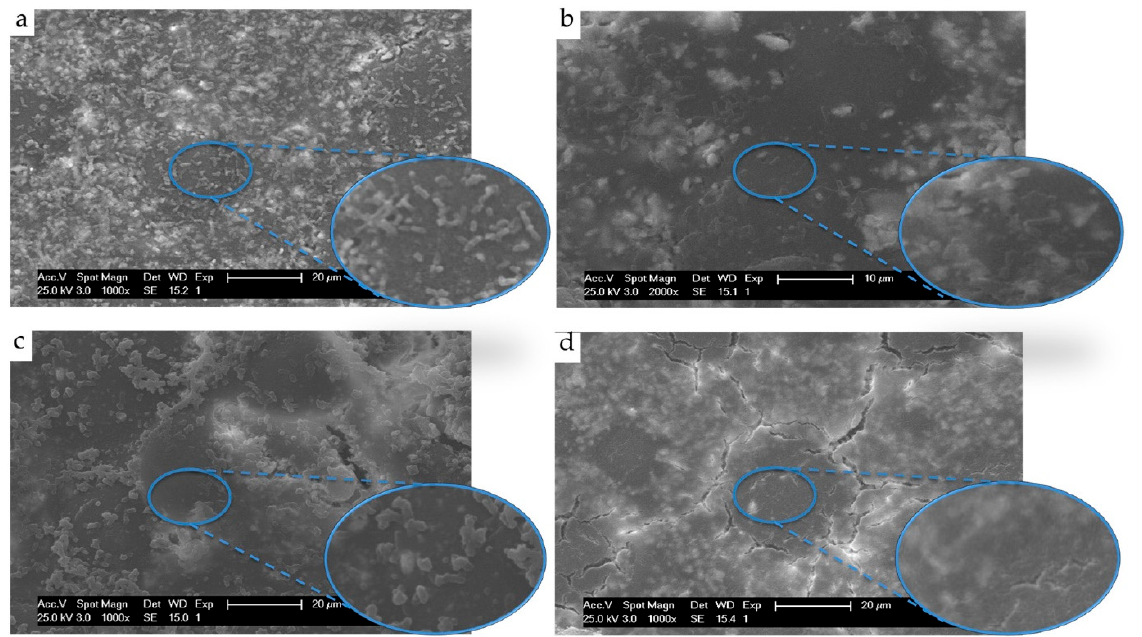
Figure 6. SEM observation of attached E. coli adhered onto ( a ) Poly(methylmethacrylate) (PMMA) acrylic surfaces, ( b ) PMMA containing 0.3% graphene oxide, ( c ) PMMA containing 15% chitosan and ( d ) PMMA containing 0.3% graphene oxide and 15% chitosan. Reproduced from Zapata et al. [116] with permission from the authors.